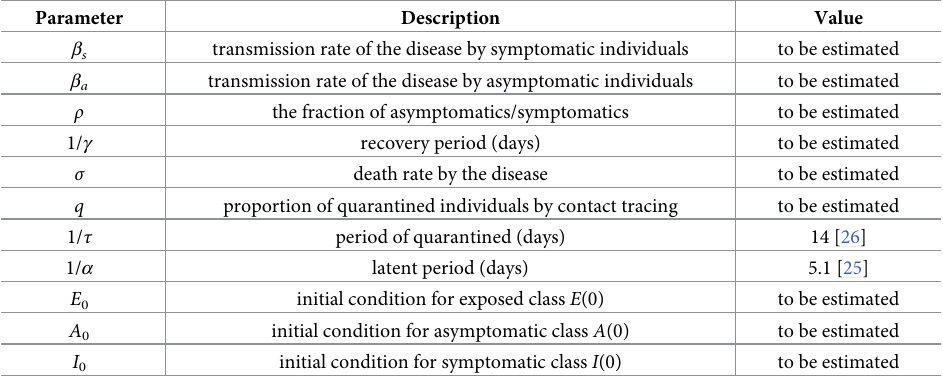
Table 1. Parameters of the contact tracing model